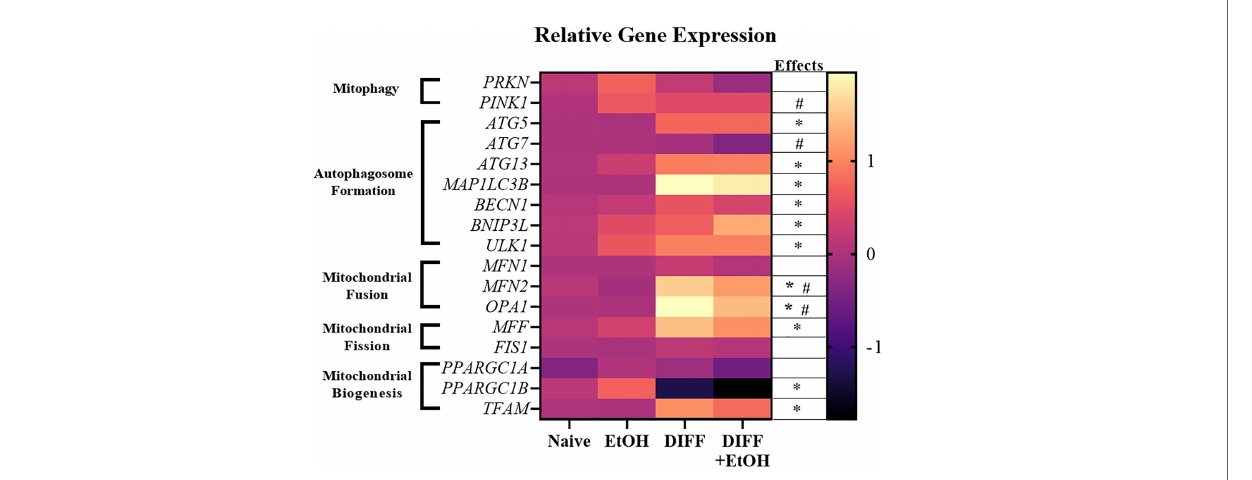
FIGURE 8 | Heat map showing increased and decreased gene expression in response to ethanol or differentiation. Data are normalized as fold change to naïve CD4 + T cell gene expression and represents data using PBMCs from 6 matched donors. Naïve = undifferentiated and no ethanol treatment, EtOH = undifferentiated and ethanol-treated, DIFF = differentiated cells and no ethanol treatment, and DIFF + EtOH = differentiated and ethanol-treated. * differentiation main effect (p ≤ 0.05). # ethanol main effect (p ≤ 0.05) as determined by repeated measures 2-way